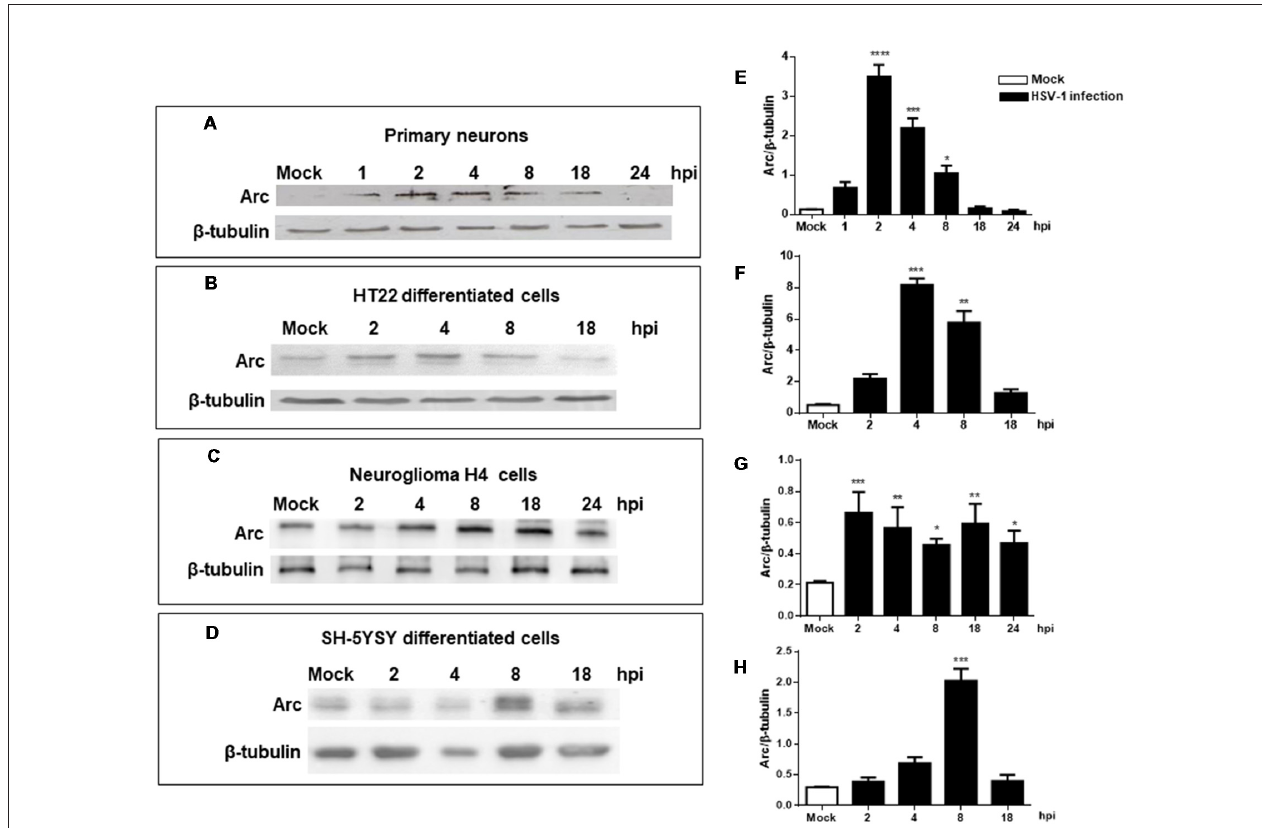
FIGURE 2 | Increased levels of Arc protein during in vitro neuronal HSV-1 infection. Immunoblot analyses showing Arc and β -tubulin proteins, in either non-infected (Mock or M) or HSV1-infected brain cells multiplicity of infection (MOI = 10). (A) Mouse primary culture neurons. (B) Differentiated HT22 cells. (C) Neuroglioma H4 cells. (D) Differentiated SH-SY5Y cells. Infections were performed at 1, 2, 4, 8, 18 and 24 hours post-infection (hpi). (E–H) After gel scanning and densitometry quantitation, the results were expressed as the ratio of Arc protein levels respect to total tubulin. The blots are representative of three independent